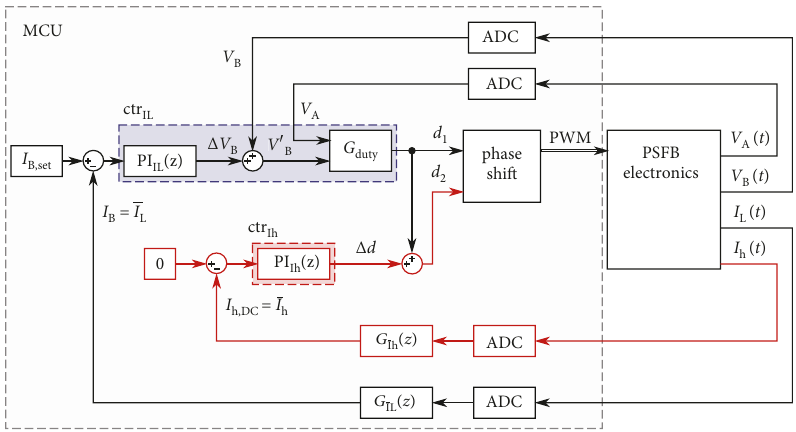
Figure 4: Control loop scheme of PSFB for I . The ctr Ih adds a small offset Δ d to d desired I B , set information into eight phase shifted PWM signals for bidirectional operation of PSFB power electronics.